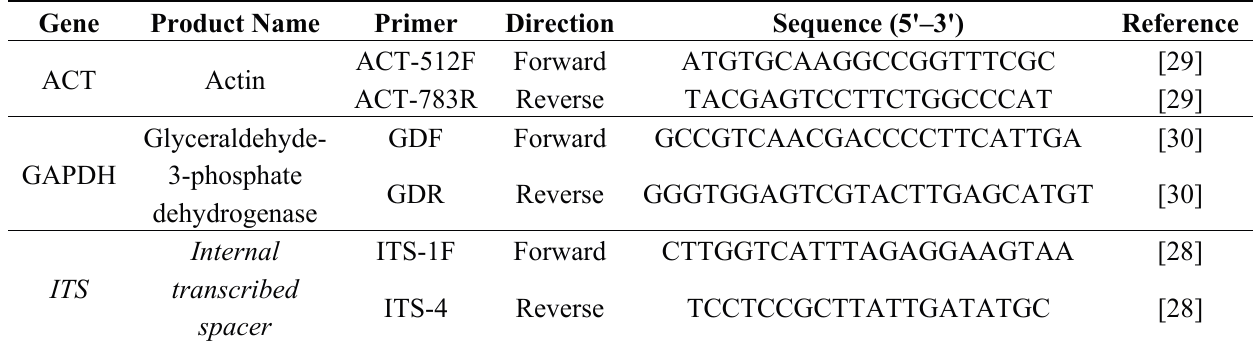
Table 3. Primers used in this study, with sequences and sources.